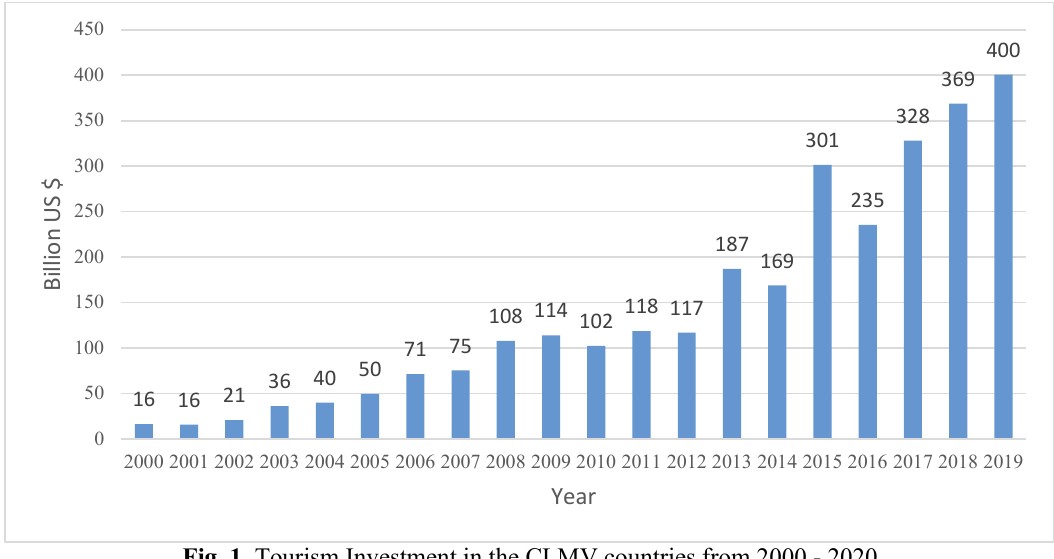
Fig. 1. Tourism Investment in the CLMV countries from 2000 -